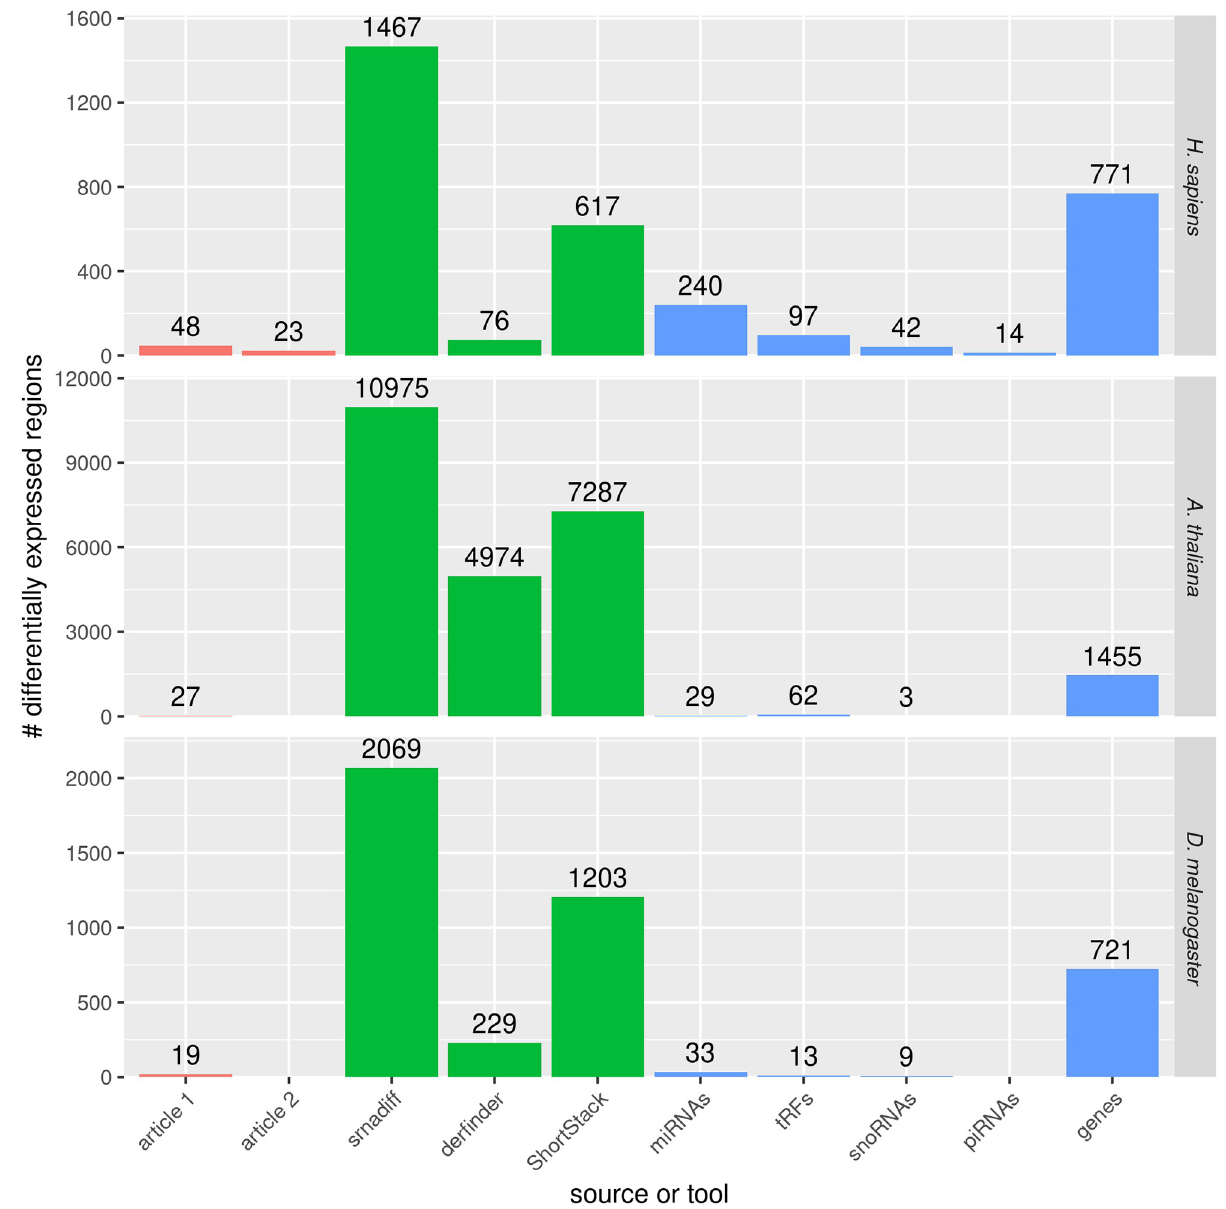
Fig 3. Number of differentially expressed regions found by each method. The red bars indicates the number of miRNAs found by [7] and [8] for the H. sapiens dataset, [36] for the A. thaliana dataset, and [40] for the D. melanogaster dataset. The green bars indicate the number of differentially expressed regions found by the three methods which are evaluated: srnadiff, derfinder, and ShortStack. The last bars give the number of elements that are found using the known annotation and the usual differential expression calling